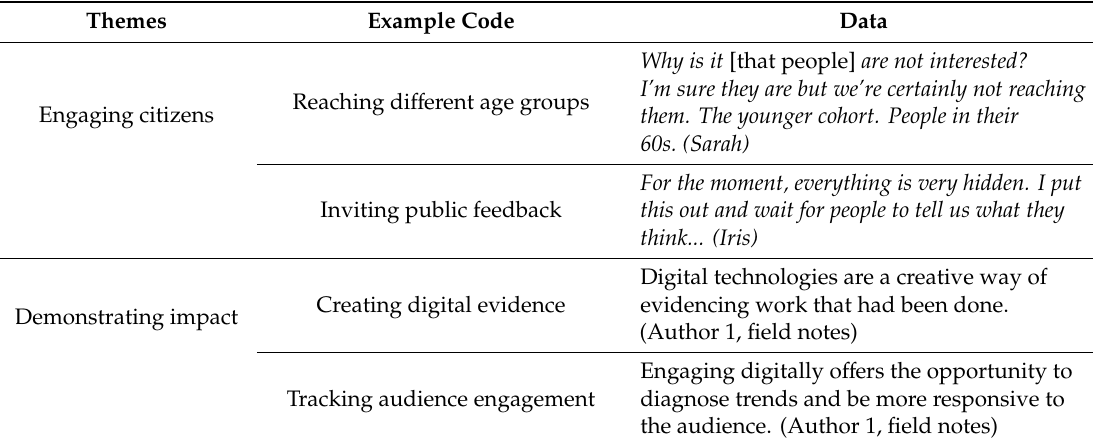
Table 3. Themes, example codes, and data from the thematic analysis exploring digital